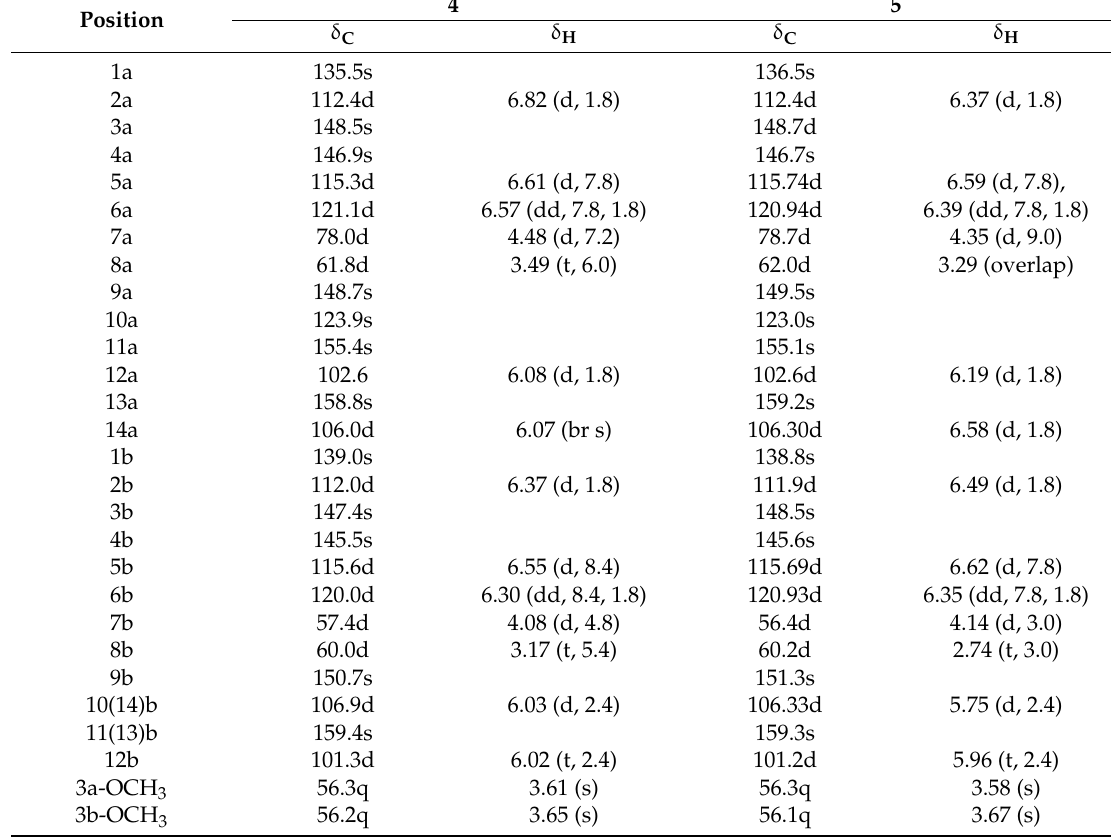
Table 1. 1 H- and 13 C-NMR spectroscopic data of 4 and 5